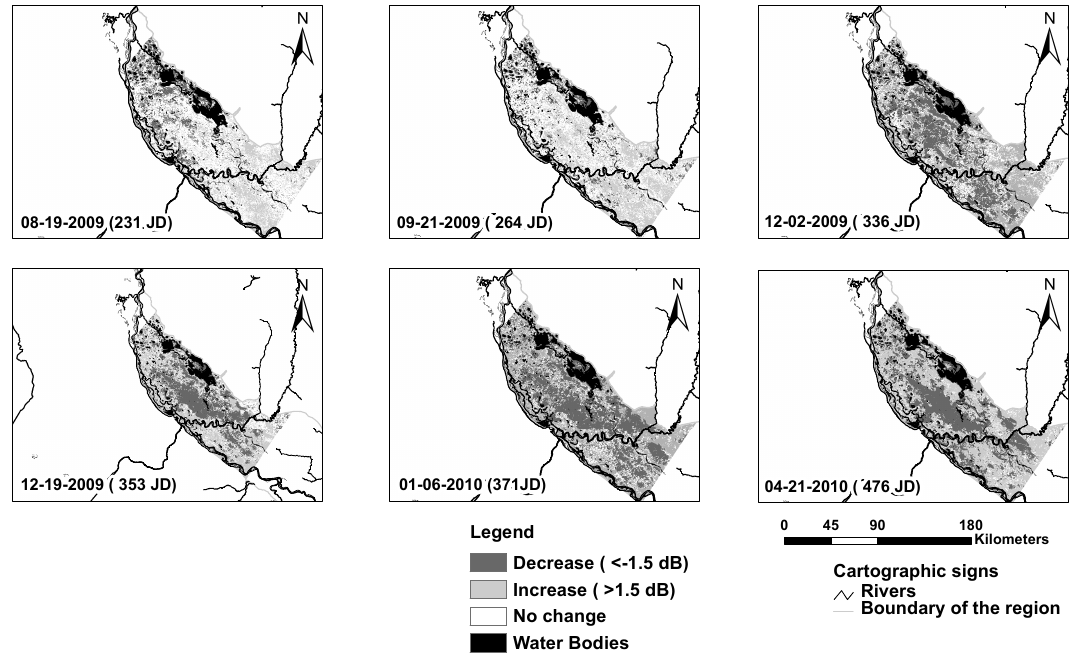
Fig. 7. Maps of σ 0 change derived from ASAR images for six dates. Julian dates starting from 1 January 2009: 231, 264, 336 (top figures), 353, 371, 476 (bottom figures).